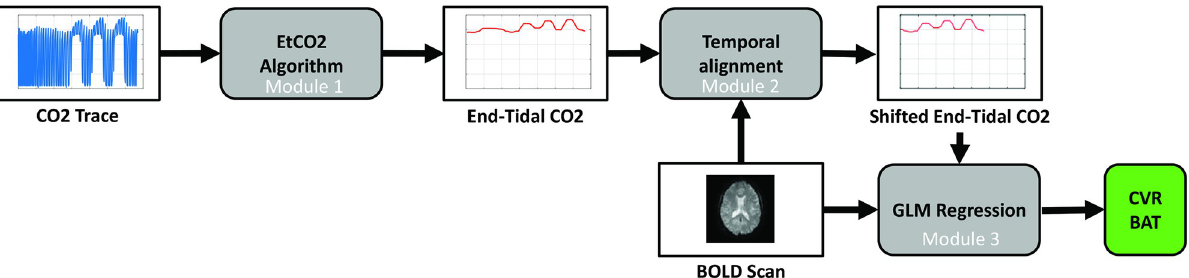
Fig 2. Flowchart of the data processing pipeline for CO2-CVR MRI data. Details of the algorithms in Module 1 through 3 are explained in the main text. CO2 –carbron dioxide; EtCO2 –end-tidal CO2; BOLD–Blood Oxygenation Level Dependent; GLM–general linear model; CVR–cerebrovascular reactivity; BAT–bolus arrival